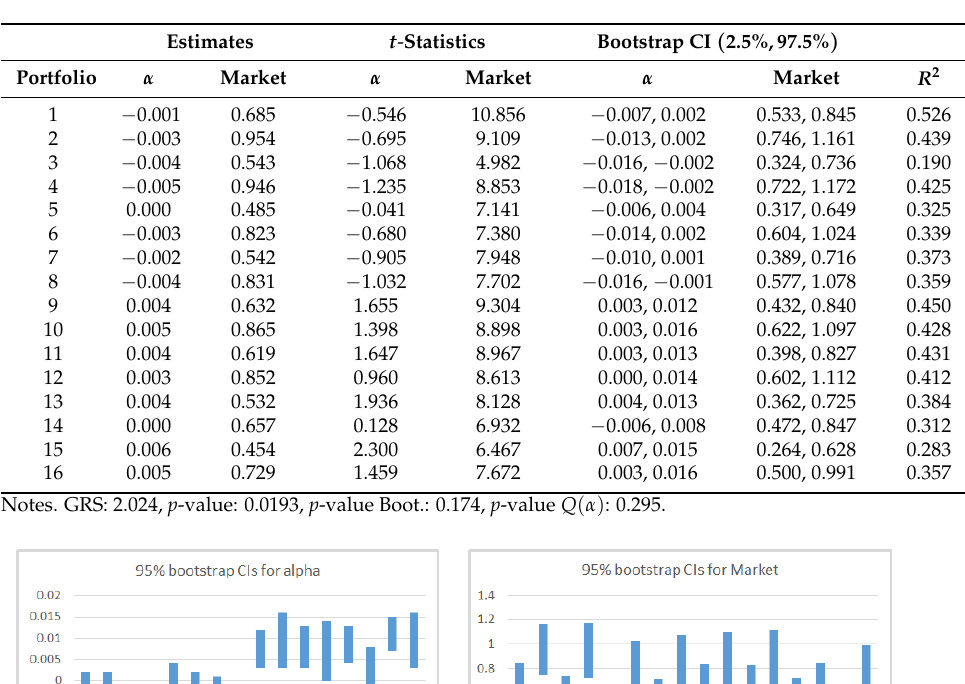
Table 7. Results for Time-Series estimation of CAPM.